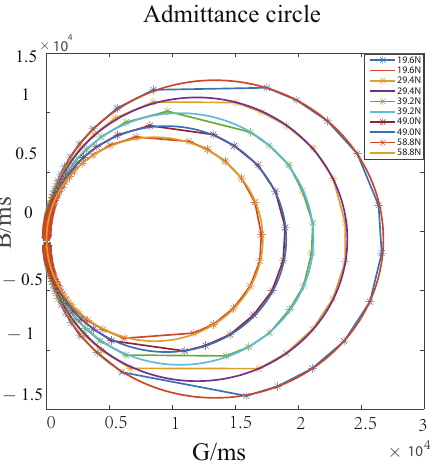
Figure 5. Admittance circle of the piezoelectric transducer under different